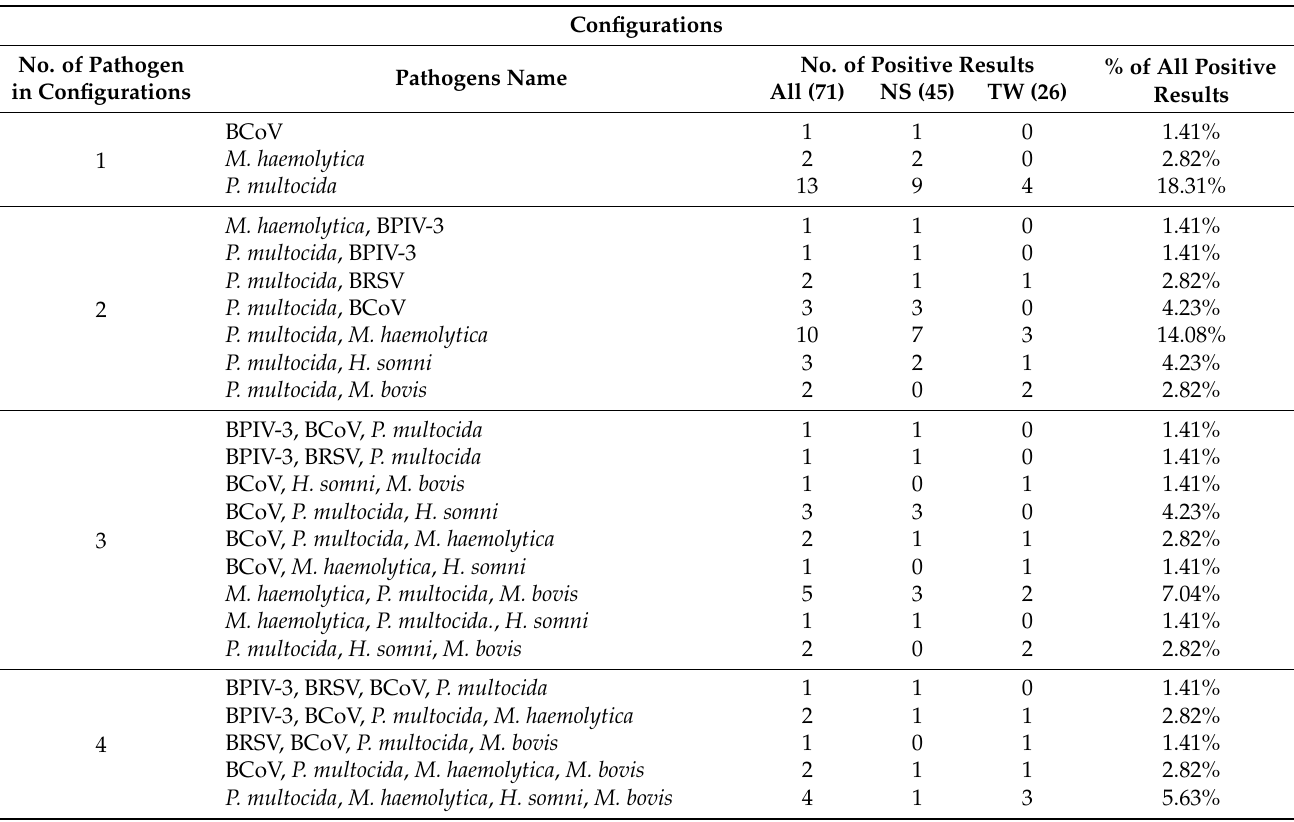
Table 2. Table showing configurations of pathogens detected, with percentages of occurrence. NS—nasal swabs, TW—tracheal